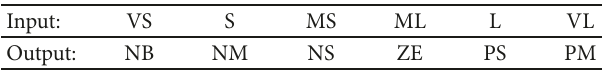
Table 2: One-dimensional rule table for fuzzy tuning